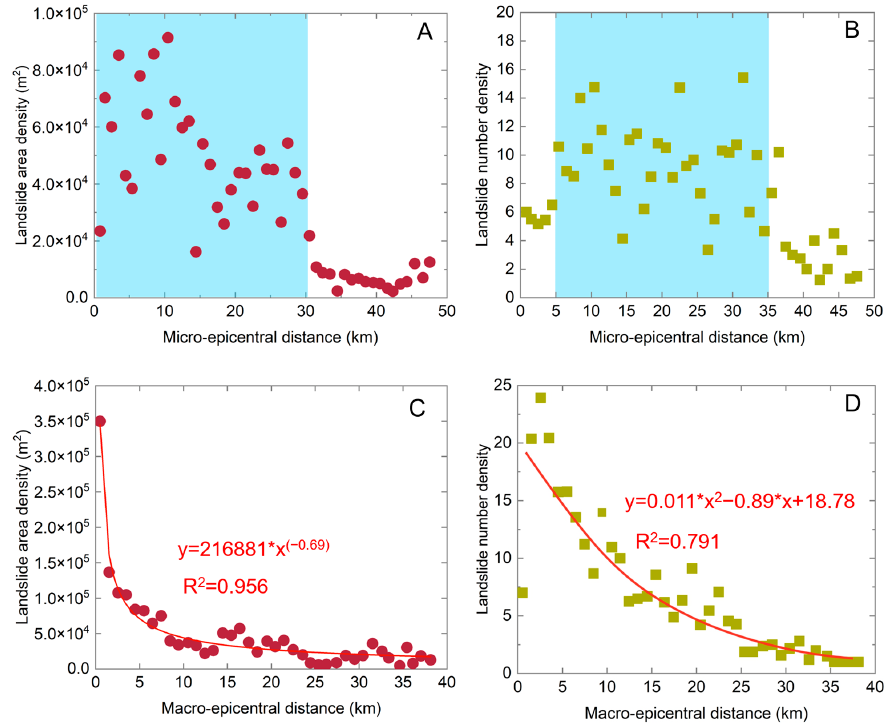
Figure 8. Correlations between epicentral distance and landslide abundance (LAD and LND). ( A , B ) micro-epicenter; ( C , D ) macro-epicenter. The spatial distribution of coseismic landslides takes on a clear gradient reduction tendency with the macro-epicentral distance in Figure 8. Based on this, considering